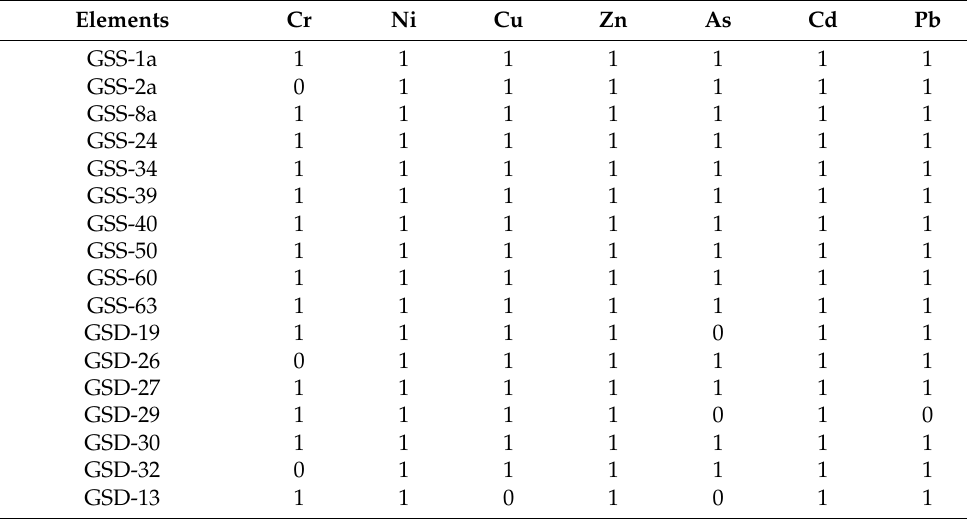
Table A4. Determination of the correctness by the MED-XRF test.